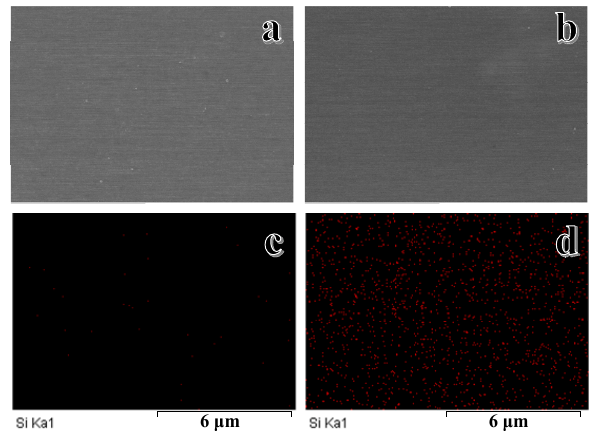
Figure 5. SEM of the PSf/PES-AM membrane ( a ) and the PSf/PES-AM-VT 3.0 membrane ( b ). Silicon distributions of the PSf/PES-AM membrane ( c ) and the PSf/PES-AM-VT 3.0 membrane ( d ).